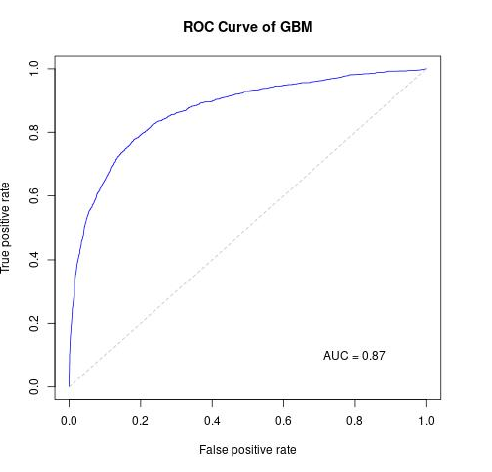
Table 4. Sensitivity, specificity, and NPV by varying cut-off in Lasso, Random Forest and Gradient Boosting Machines.